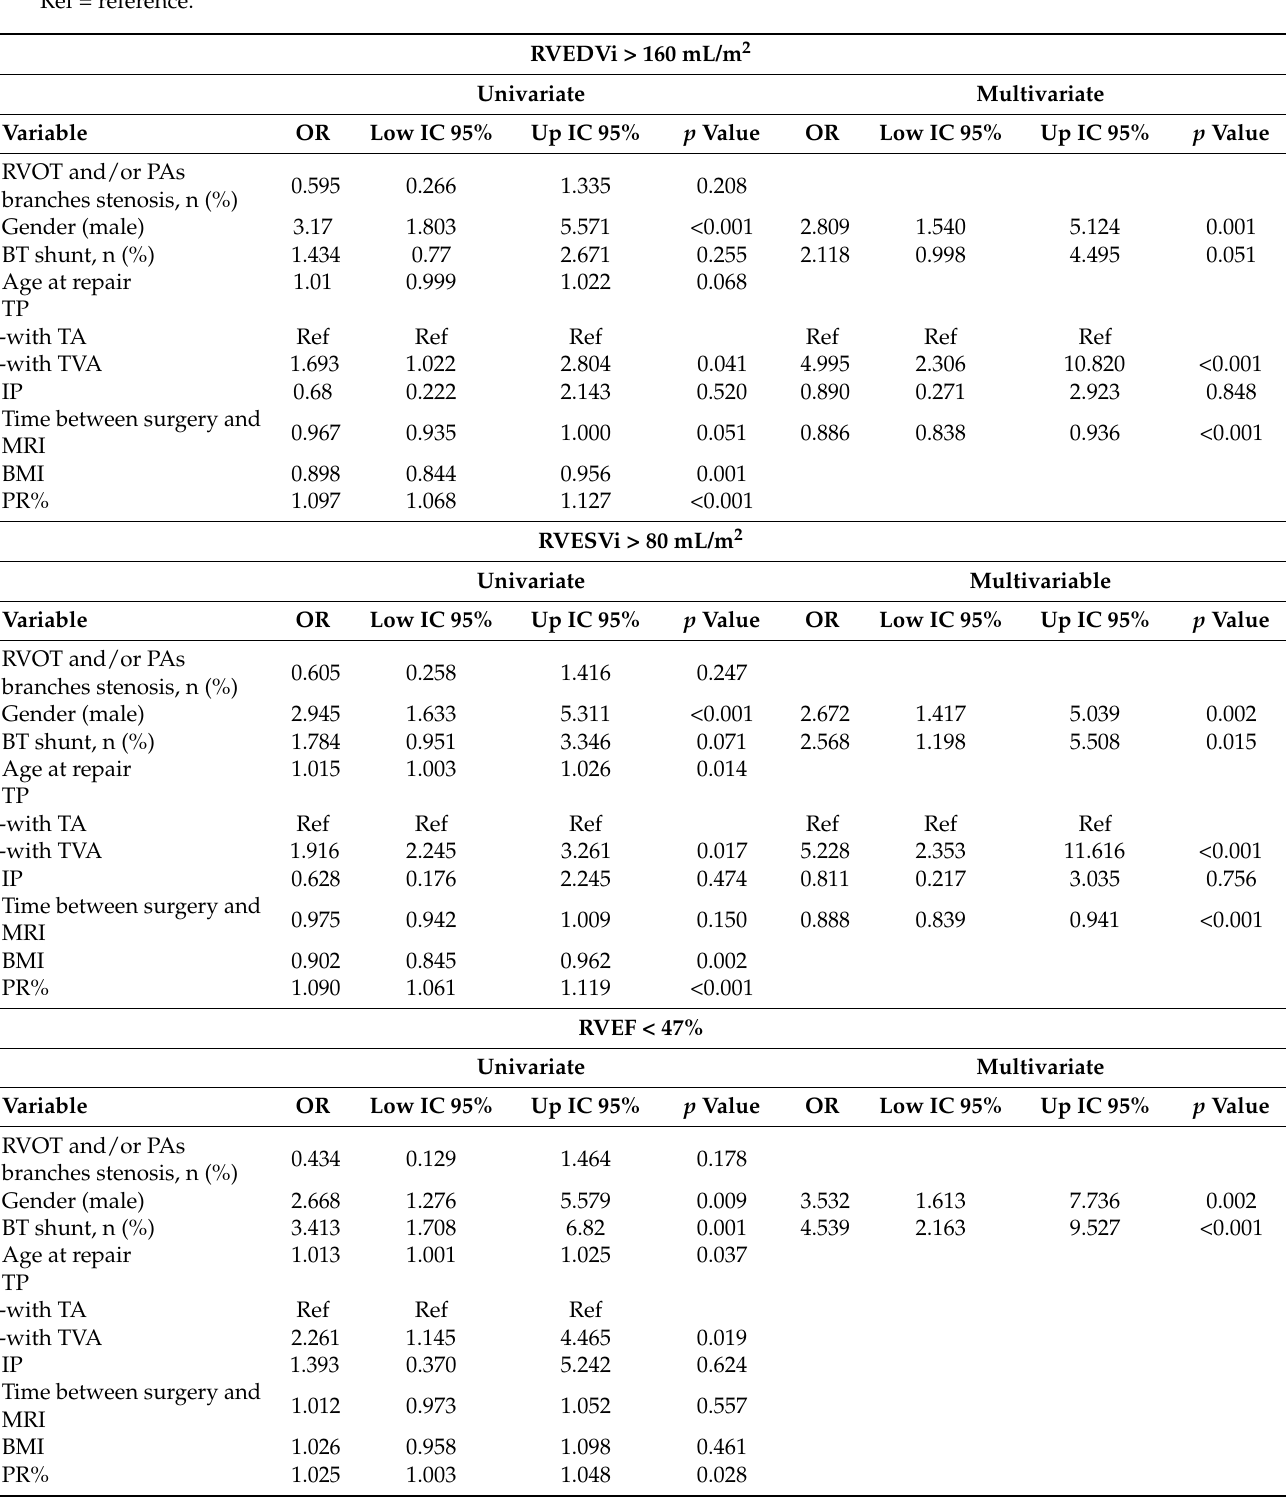
Table 6. Predictors of RV dilation and dysfunction, LV dysfunction. Legend: RVOT = right ventricular outflow tract; PAs = pulmonary arteries; BT shunt = Blalock–Taussig shunt; TP = transannular patch; TA = transatrial approach;